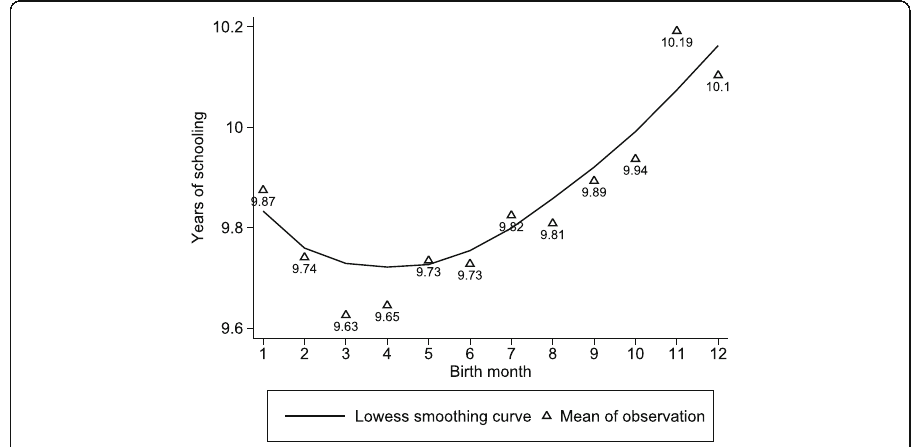
Fig. 2 Average years of schooling by birth month, for birth cohorts 1979 –